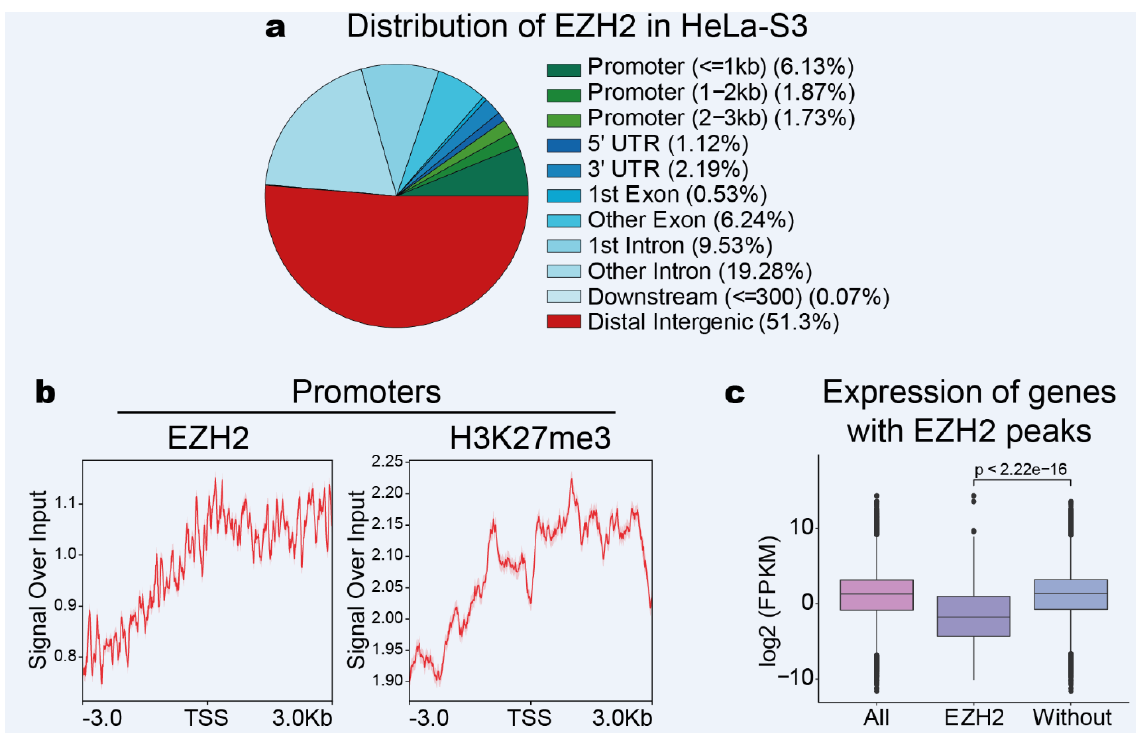
Figure 3: EZH2 enrichment at promoters in HeLa-S3 promotes transcriptional repression. a) Ge- nomic annotation of EZH2 peaks in HeLa-S3. b) Profile plots of EZH2 and H3K27me3 enrichment around the TSS. The signal intensity of EZH2 and H3K27me3 are shown concerning the input. c) Box plot of the transcription levels of genes with EZH2 enrichment at promoters in HeLa-S3. Wilcoxon test, p-value